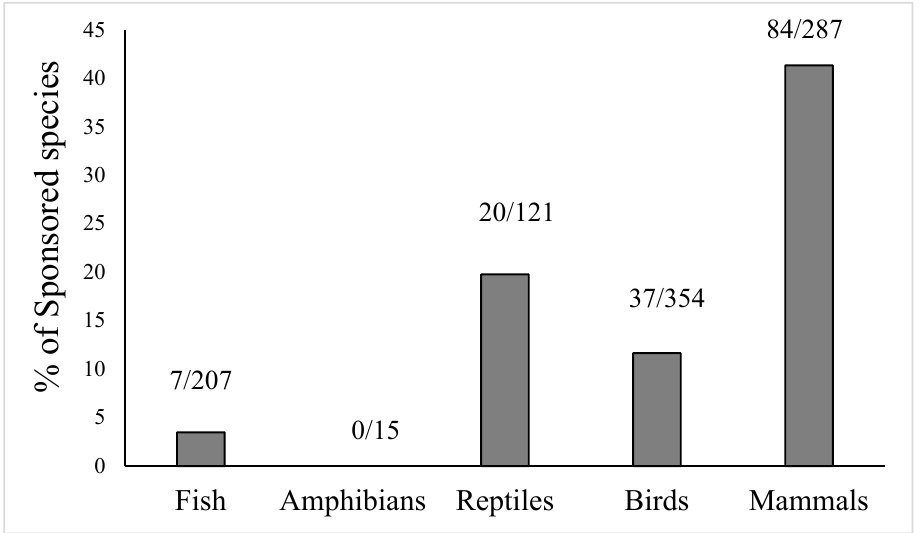
Figure 2. Distribution of sponsoring occurrences among vertebrate classes.